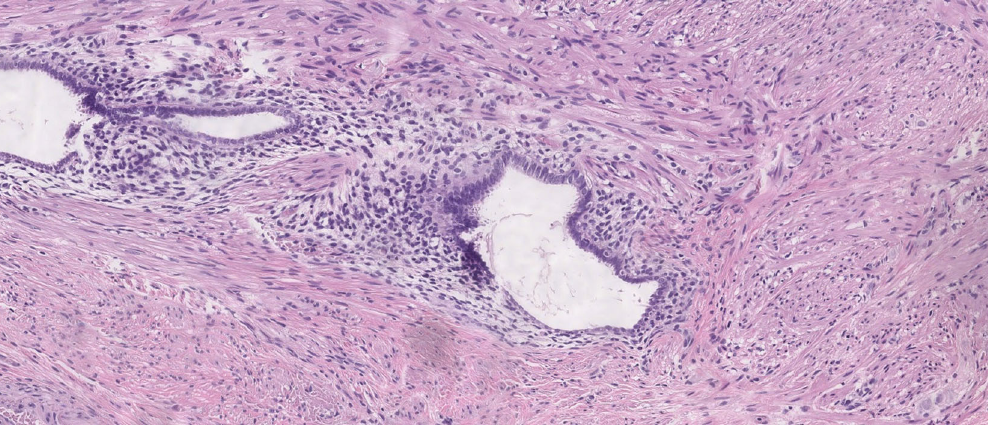
Figure 3: Magni fi cation 100 ×